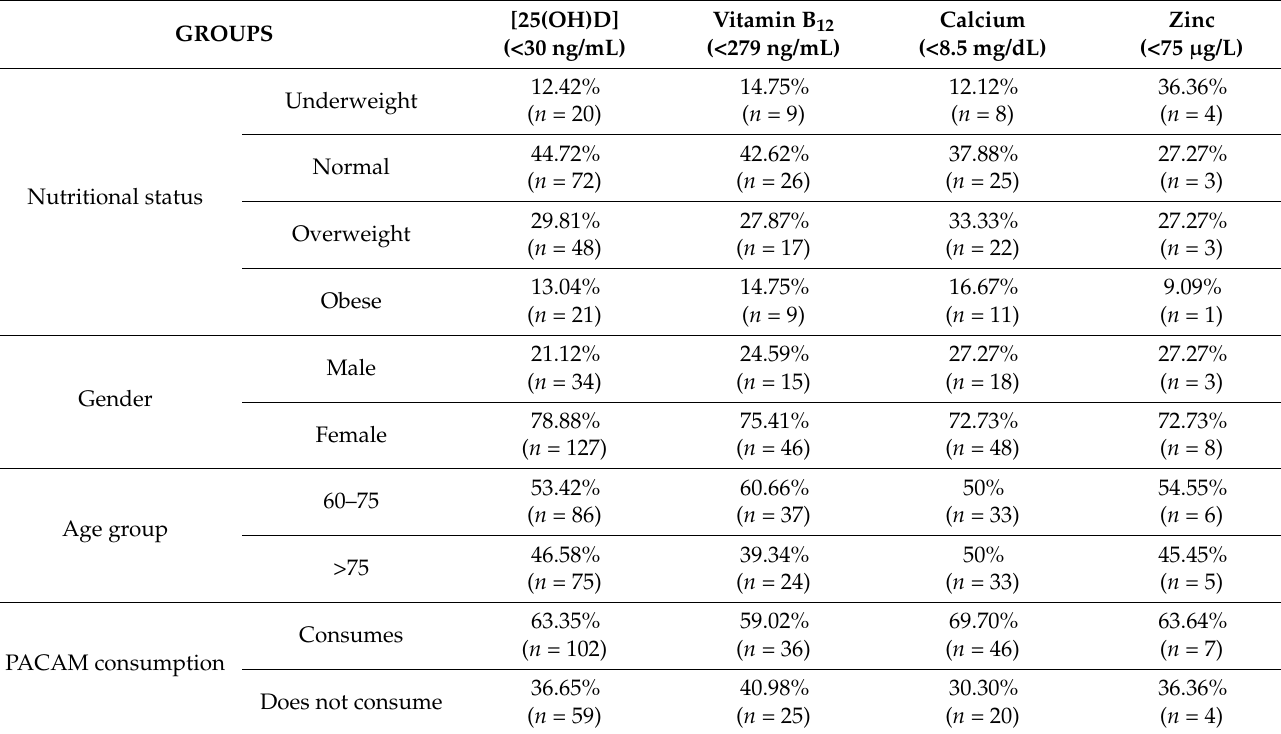
Table 5. Influence of the nutritional status, gender, age and PACAM foods consumption on the micronutrient serum deficiencies of Chilean older